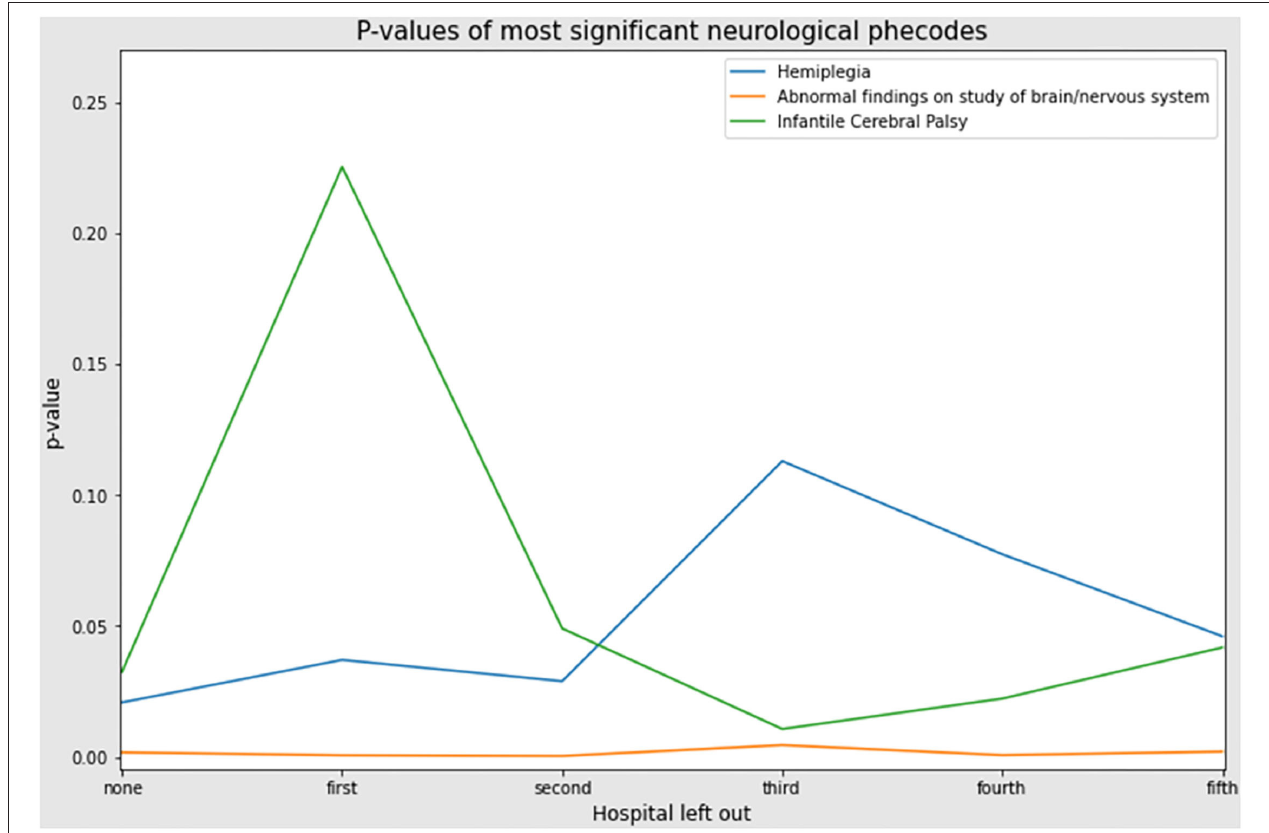
FIGURE 4 | Sensitivity analysis. Graph of leave one out analysis; p -value on y-axis and rank order contributing hospitals on x-axis. The top patient contributing hospital was left out prior to propensity score matching and data analysis rerun including Fisher’s exact test. This was performed sequentially for each of the top hospitals. Results of p -value for the phecode, abnormal findings on study of brain/nervous system, remained similar. However, the p -values for infantile cerebral palsy and hemiplegia fluctuated substantially when the first and third hospitals were left out, respectively. This indicates that these hospitals were skewing the frequencies for these two phecodes, and that it is not an overall trend in the